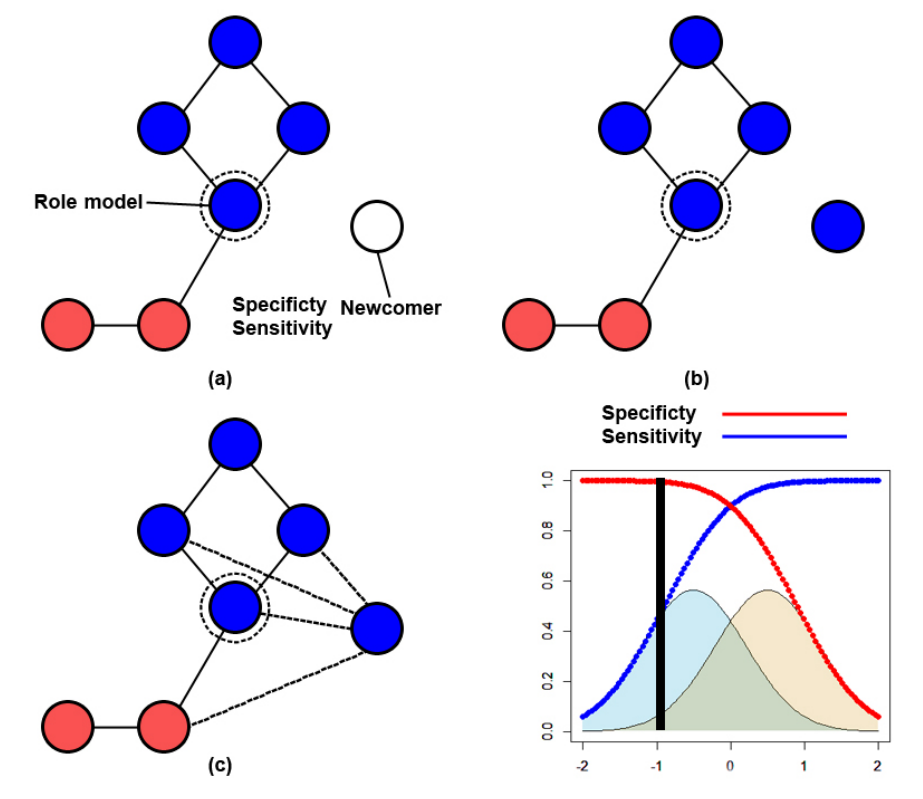
Figure 2. An illustration of the process that is undertaken as a newcomer joins the network at each step during the simulation. Firstly, a newcomer will select an existing node to act as its role model, which is influenced by both nodes current payoff and the current selection strength ( a ). Following this, the newcomer will adopt a strategy, by either copying the role model or mutating ( b ). Lastly, the newcomer will then proceed to choose which of the role models neighbours to form connections with, which is achieved by making use of available public and private information ( c )